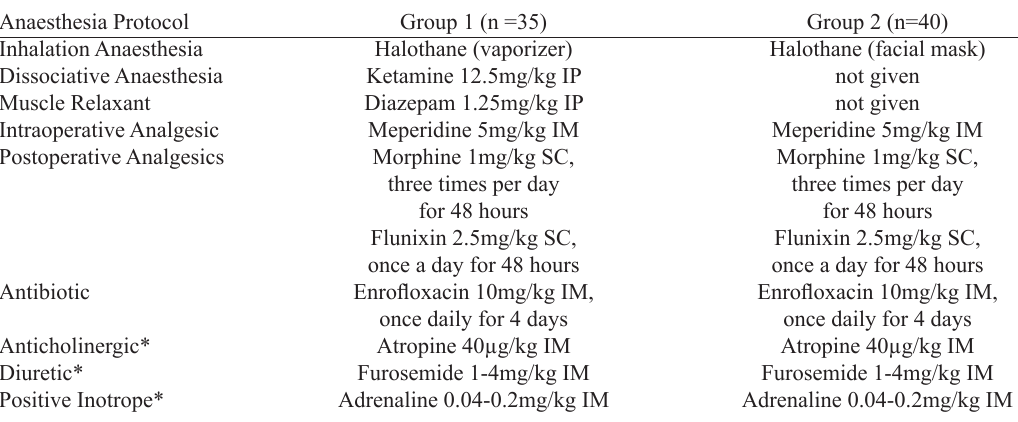
Table 1. Details of the pre-medication and anaesthetic protocols and the peri-and post-operative medications of the two groups of rats in whom an acute myocardial infarction (AMI) was